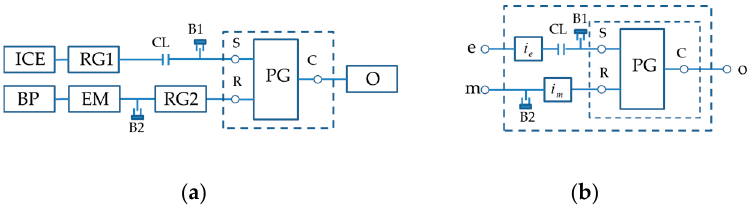
Figure 10. Type-a typical architecture: ( a ) the basic compact hybrid planetary transmission drive (CHPTD); ( b ) three-port diagram. (RG—reduced gear; CL—clutch;